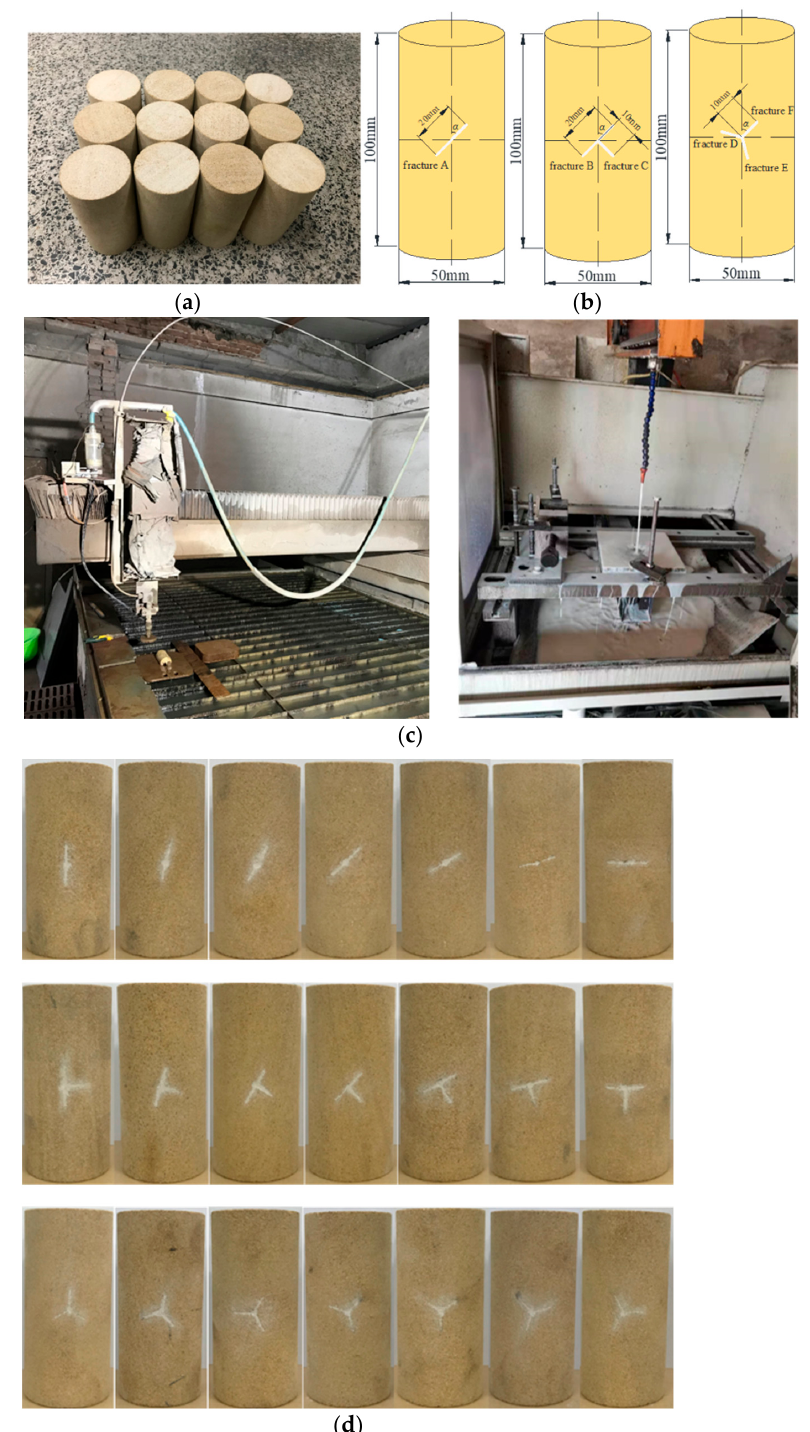
Figure 1. Preparation process of multi-shape fractured sandstone samples: ( a ) standard samples; ( b ) prefabricated fracture-size models; ( c ) fractures cutting equipment; and ( d ) prefabricated fracture samples. Table 1. Test scheme of fractured sandstone samples.